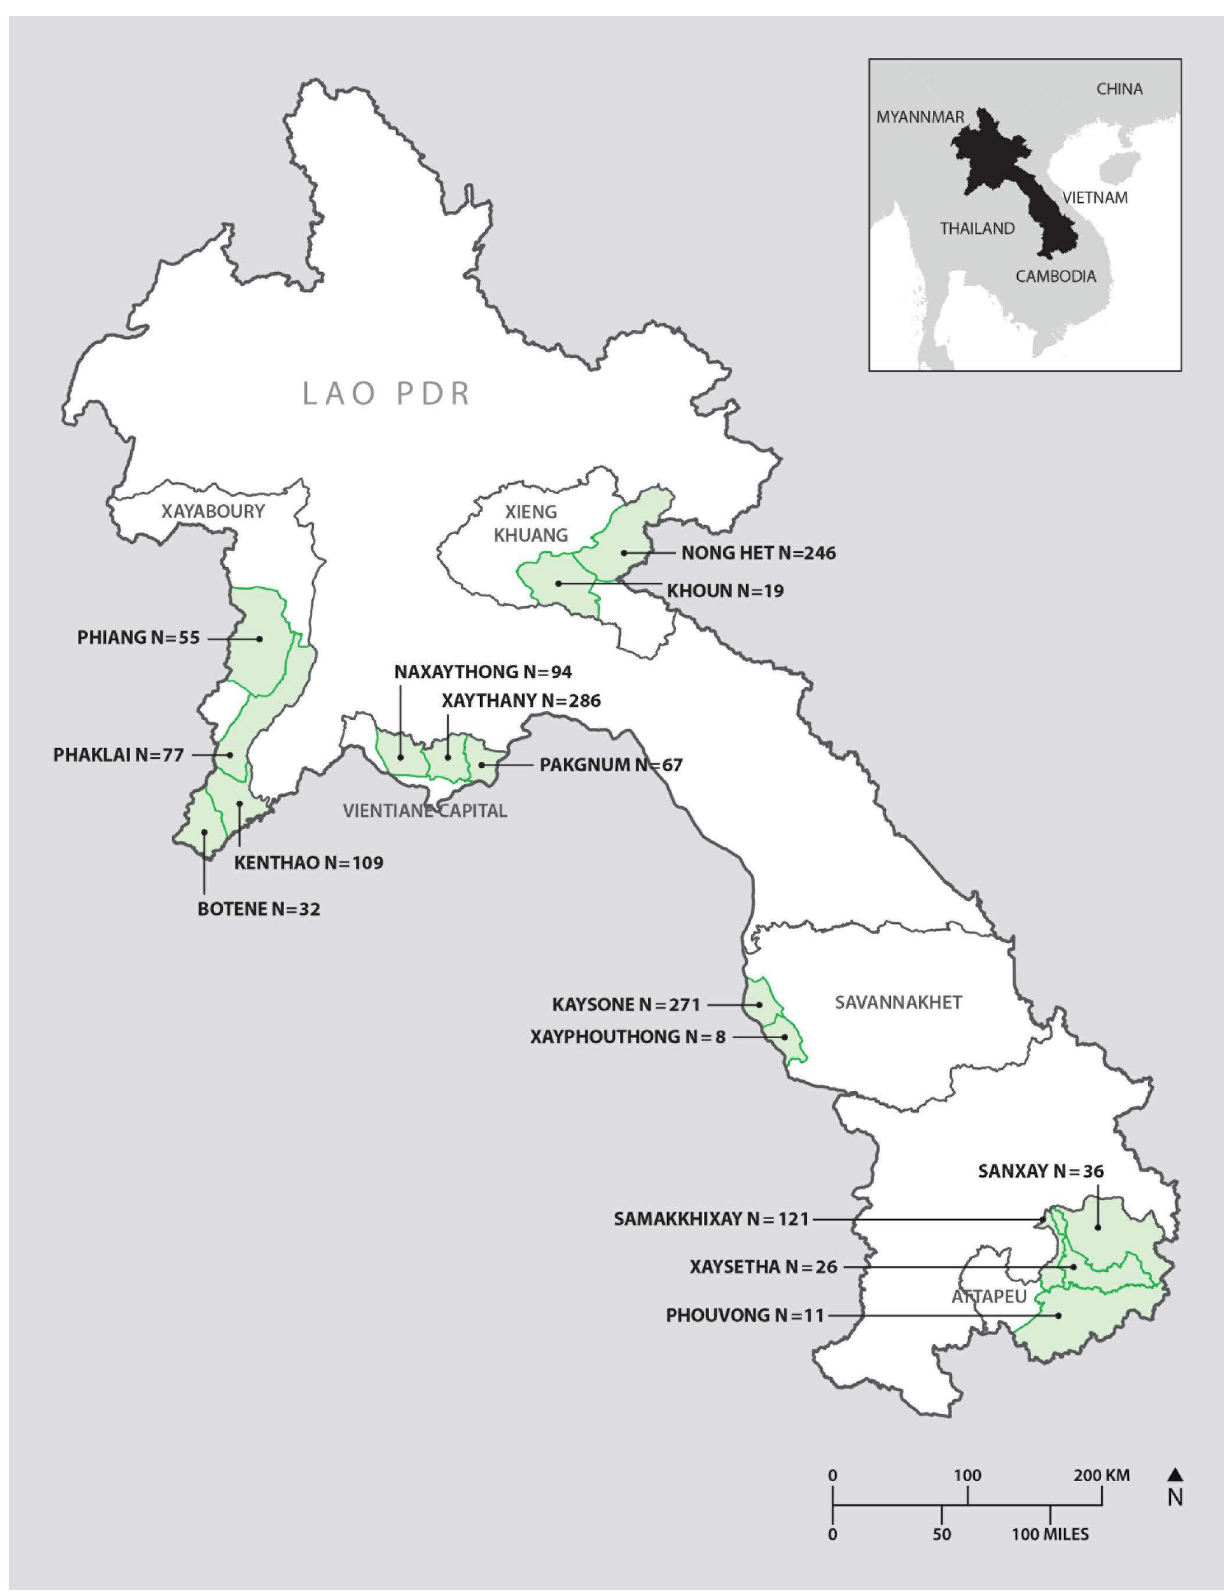
Fig 1. Map of Laos and districts sampled in this study. Numbers of samples collected in each location is indicated.